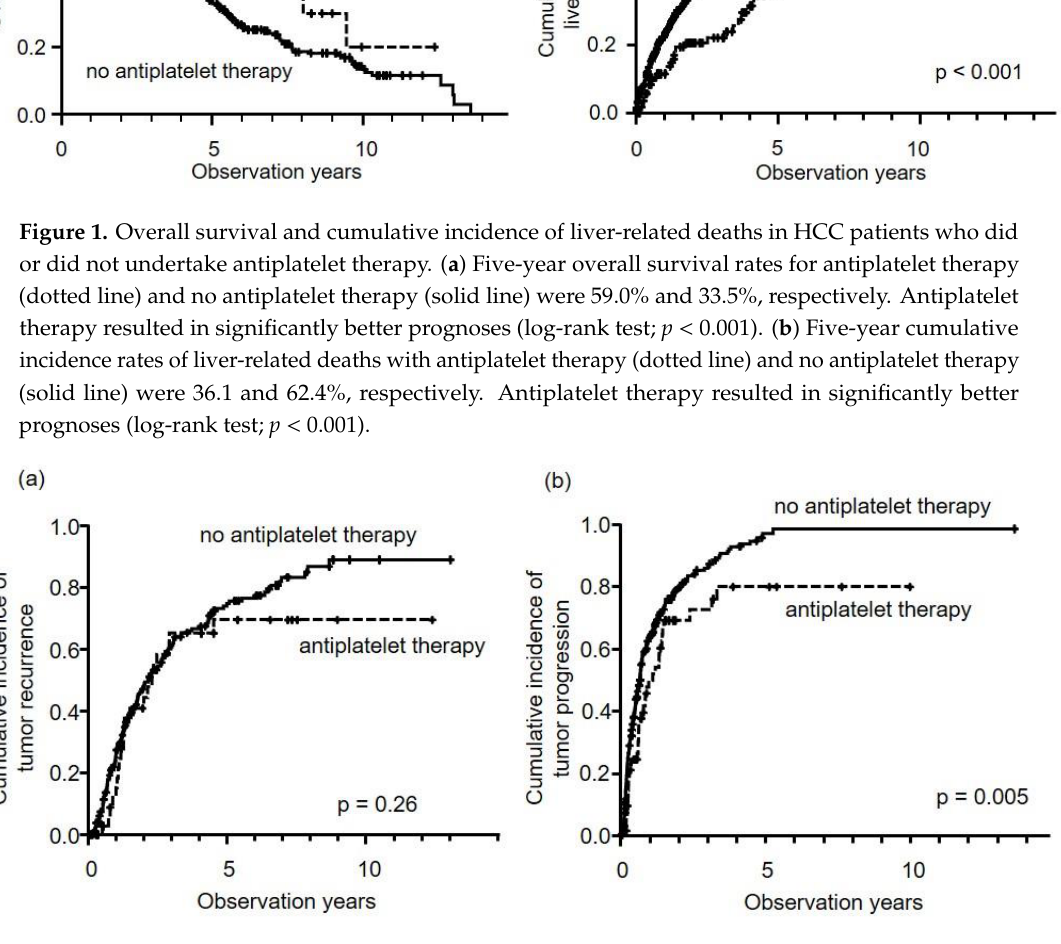
Figure 2. Cumulative incidence of tumor progression stratified by first treatment method, i.e., curative therapy ( a ) and TACE ( b ). In curative therapy ( a ), antiplatelet therapy (dotted line) had no effect on HCC recurrence ( p = 0.26), compared to no antiplatelet therapy (solid line). However, in TACE ( b ), antiplatelet therapy was associated with significantly longer times to tumor progression. Five-year cumulative incidence rates for antiplatelet therapy (dotted line) and no antiplatelet therapy (solid line) were 80.0% and 97.1%, respectively ( p = 0.005). Table 3. Baseline factors associated with tumor progression in patients who underwent TACE in univariate and multivariate Cox regression analyses.